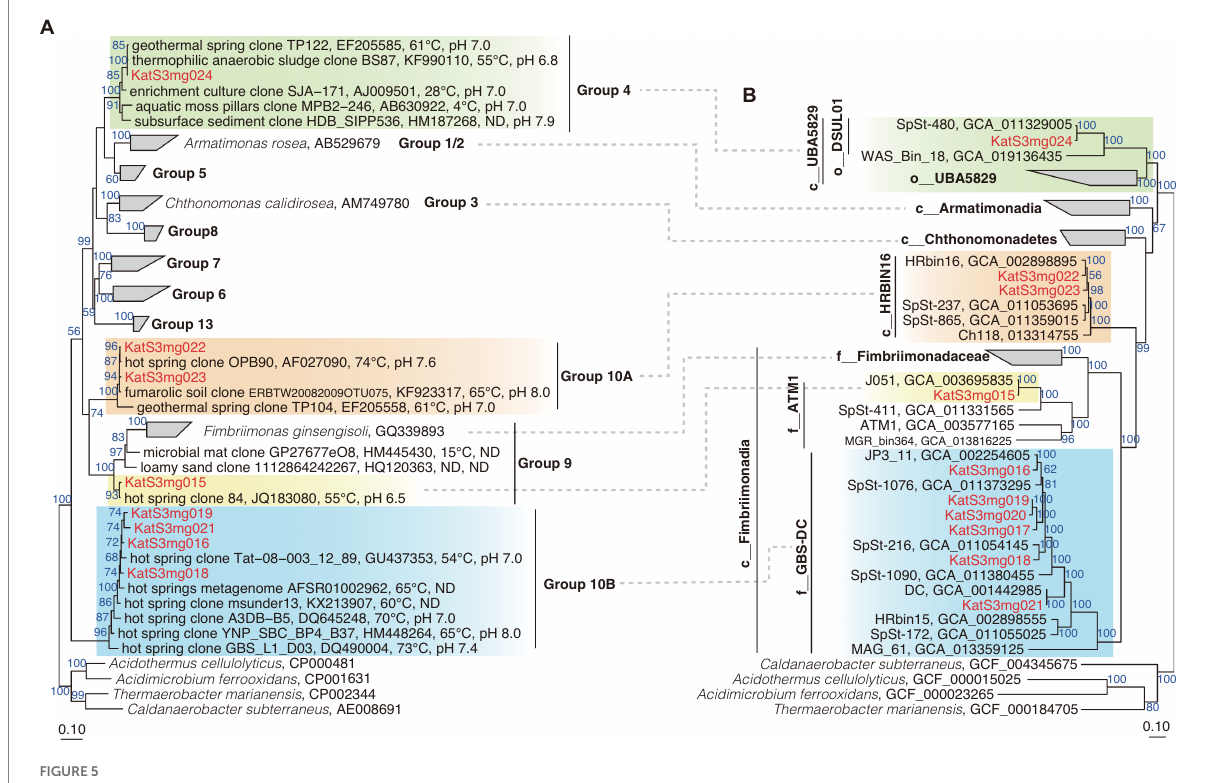
FIGURE 5 Phylogeny of Armatimonadota . (A) Phylogenetic tree of 16S rRNA genes and (B) Phylogenomic tree based on 120 bacterial marker proteins are shown. The MAGs obtained in this study are colored in red. Group numberings shown in the 16S rRNA gene tree (A) are originated from the previous report (Lee et al.,